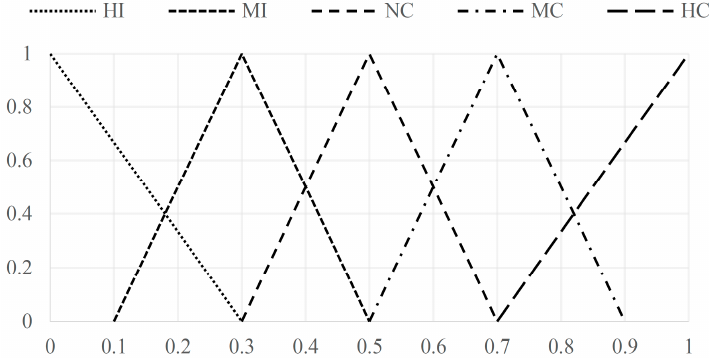
Figure 1. Membership functions of linguistic values for determining compatibility between land-uses.